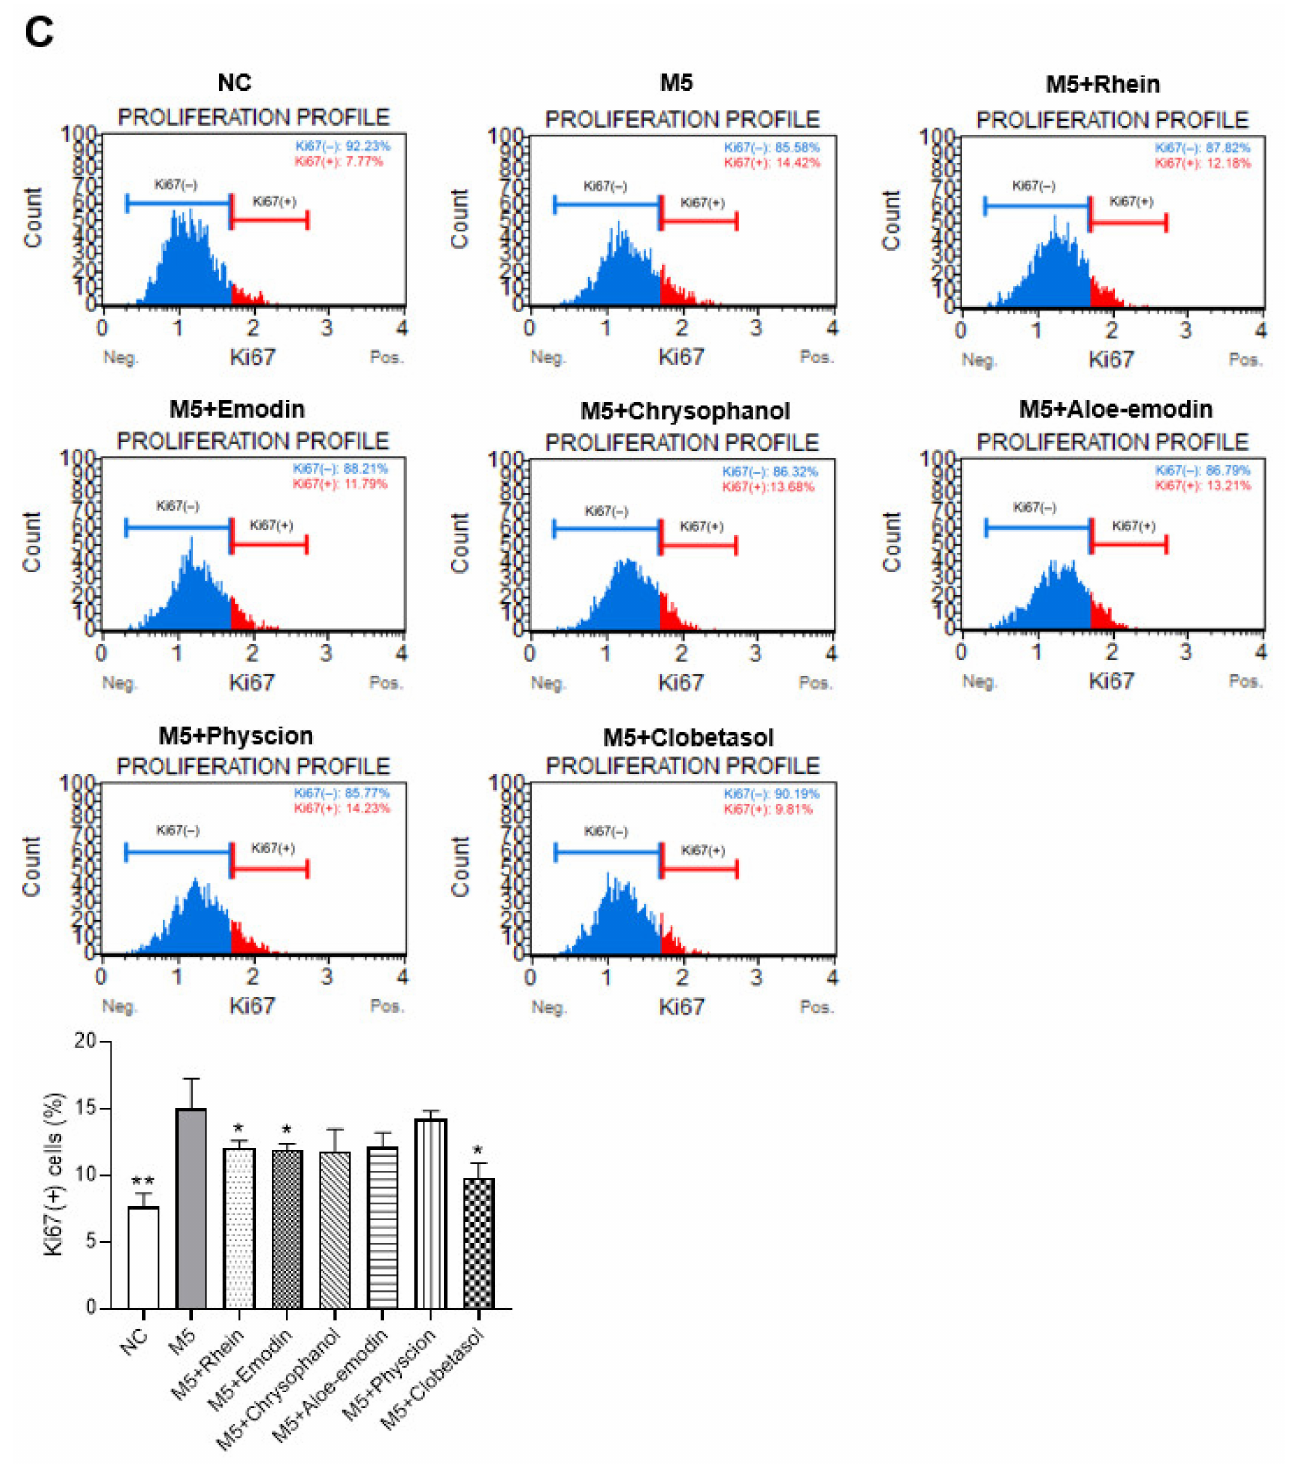
Figure 7. Effects of RPE compounds on the inflammatory response and proliferation in M5-stimulated HaCaT cells. ( A ) HaCaT cell viability was evaluated using XTT assays. ( B ) Effect of RPE compounds on the production of CXCL8, CXCL10, CCL20, and MMP9 in HaCaT cells stimulated with M5 (TNF- α , oncostatin M, IL-1 α , IL-17A, and IL-22, 10 ng/mL each) was examined by ELISA assays. ( C ) The effect of RPE compounds on hyperproliferation in M5-stimulated HaCaT cells was measured using the Muse Ki67 Proliferation kit. Data are expressed as means ± SDs ( n = 3 per experiment). # p < 0.05 vs. normal control (NC); * p < 0.05, ** p < 0.01, *** p < 0.001 vs. M5-treated cells. CXCL: chemokine (C-X-C motif) ligand, CCL: CC chemokine ligand, and MMP: matrix